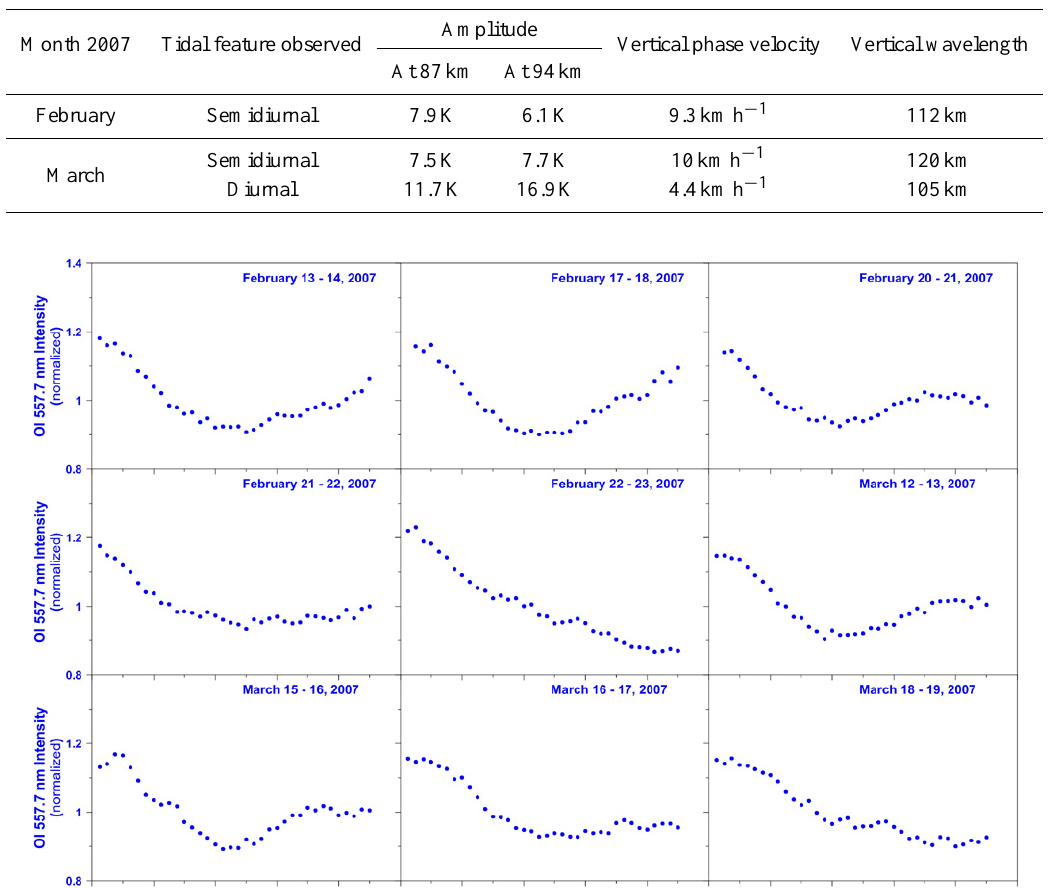
Table 3. Characteristics of semidiurnal and diurnal tidal features inferred using the sinusoidal least square fitting method.